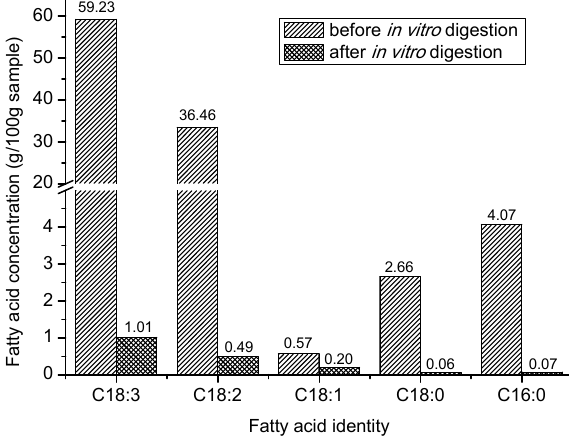
Figure 3. Relative concentration of fatty acids in sacha inchi oil (SIO) samples before and after the simulated gastrointestinal digestion.